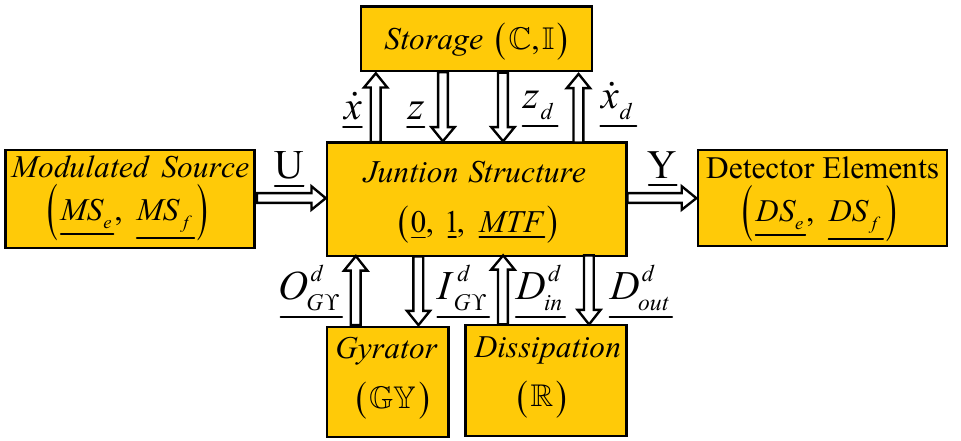
Figure 10. Multibond graph in a derivative causality Figure 8 . Multibond